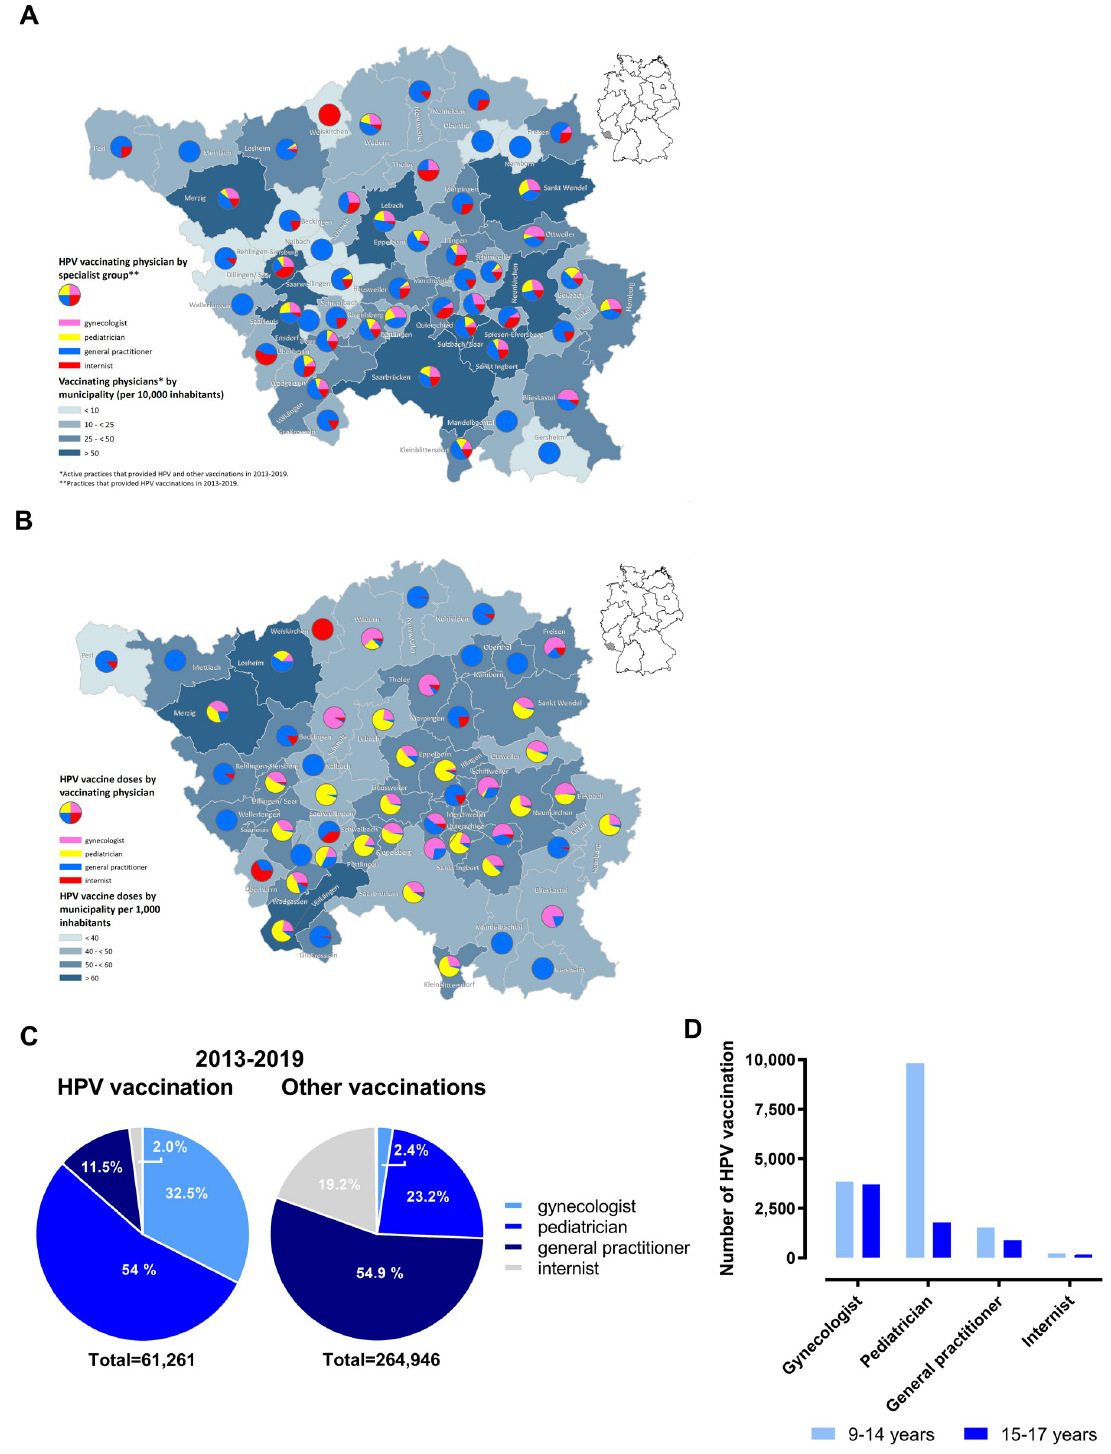
Fig 2. Relationship between HPV vaccination and vaccinating medical specialists. (A) Cartographic distribution of the vaccinating doctors by medical specialty (gynecologists, pink; pediatricians, yellow; general practitioners, blue; internists, red) based on Saarland municipality and per 10,000 inhabitants (data KVS 2013–2019). Administrative boundaries from © GeoBasis-DE / BKG 2020; Data License Germany—Attribution—Version 2.0; Terms of use: http://sg.geodatenzentrum.de/web_public/nutzungsbedingungen.pdf. (B) Cartographic distribution of HPV vaccination doses by medical specialty and by Saarland municipalities, weighted according to the